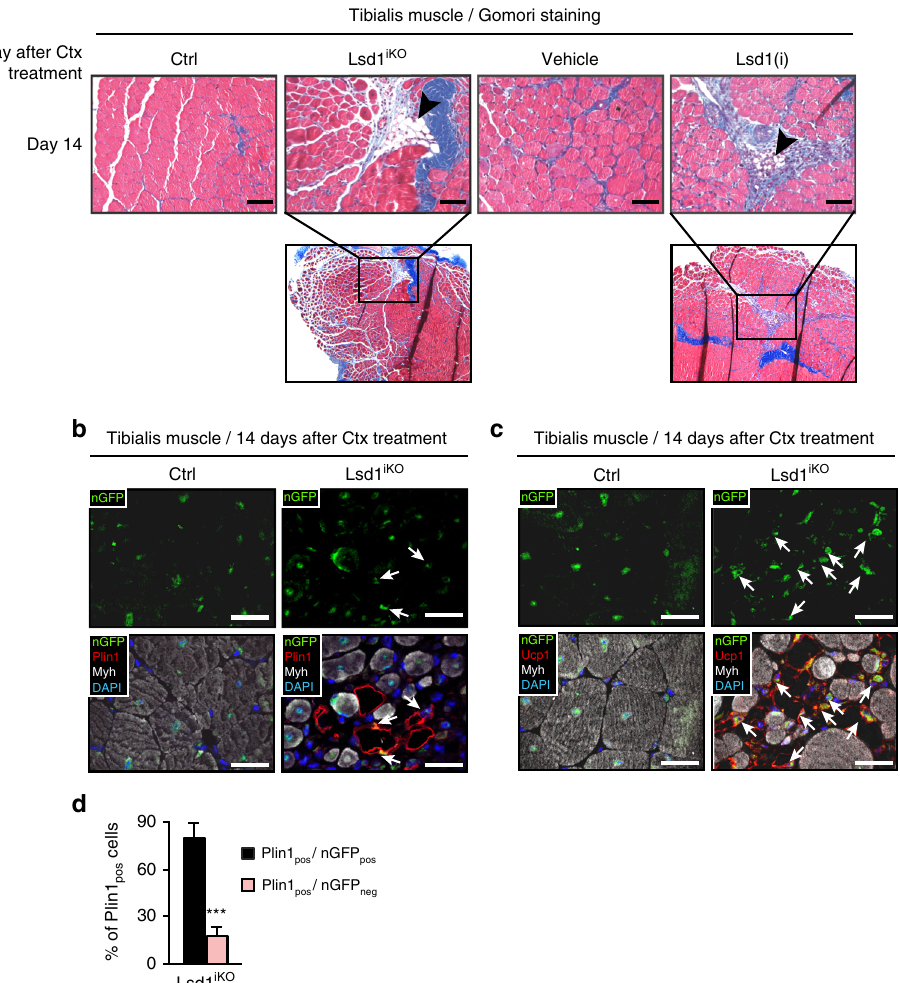
Fig. 3 Loss of Lsd1 favors differentiation of satellite cells into brown adipocytes. a – d Representative tibialis muscle sections from Ctrl, Lsd1 iKO , and Lsd1(i) mice 14 days after Ctx injection. a Gomori staining. Arrowheads indicate fat accumulation. b , c Immuno fl uorescence assays using antibodies directed against GFP (green), Myh (white), and b perilipin 1 (Plin1, red) or c uncoupling protein 1 (Ucp1, red) as indicated. Nuclei were stained with DAPI (blue). Arrows indicate adipocytes that express nuclear GFP (nGFP) and therefore originate from satellite cells. d Percentage of Plin1-positive cells that express or do not express nGFP. Signi fi cance was calculated by two-tailed Student ’ s t -test. ( d : n = 6; mean + SEM, *** p < 0.001; scale bars: a 100 µ m, b , c 50 µ